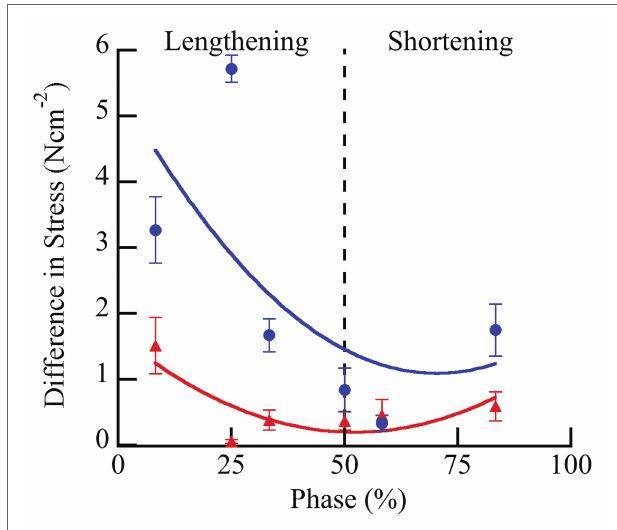
FIGURE 4 | Differences in peak stress with vs. without doublet stimulation across phase of stimulation in wild type (blue) and mdm (red) soleus. Doublet potentiation of peak stress is reduced in mdm muscles compared to wild type at all phases of activation ( F = 52.3, p < 0.0001). Phase = 0% indicates a muscle at its shortest length at the onset of lengthening and phase = 50% indicates a muscle at its longest length just prior to shortening. Data represent means ± SE, N = 28 individuals, 112